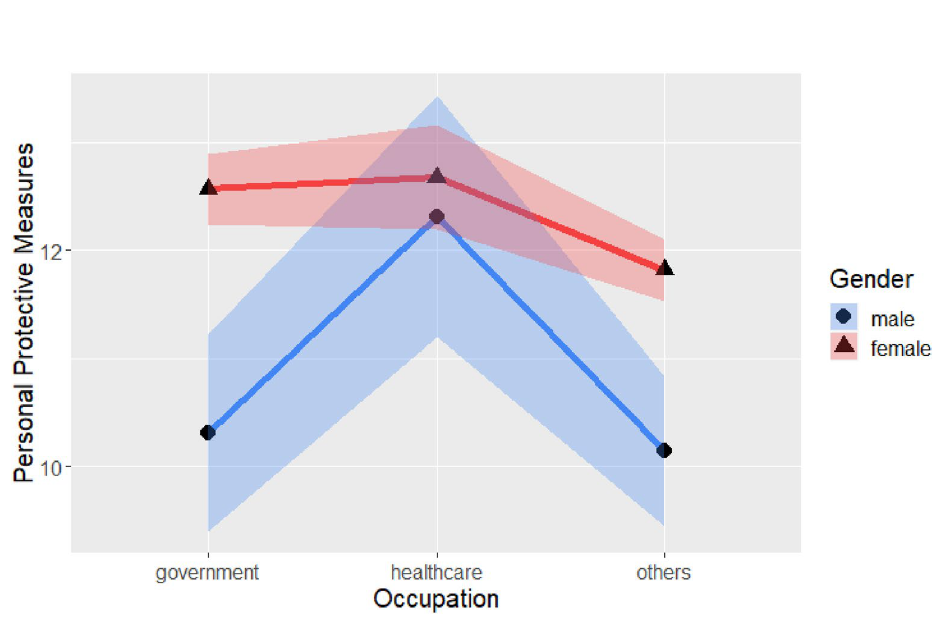
Figure 7. Personal protective measures with gender and